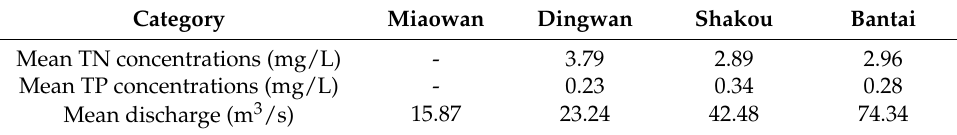
Table 2. Mean TN and TP concentrations and discharge for the studied stations in 2006–2010.